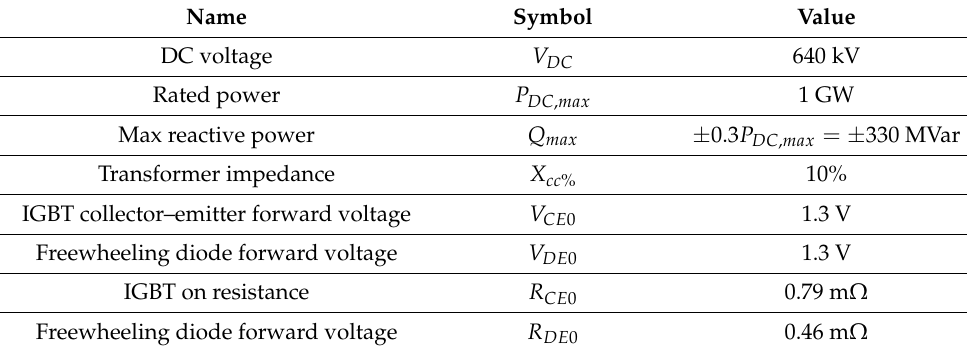
Table 1. Parameter numerical values for both of the converters.